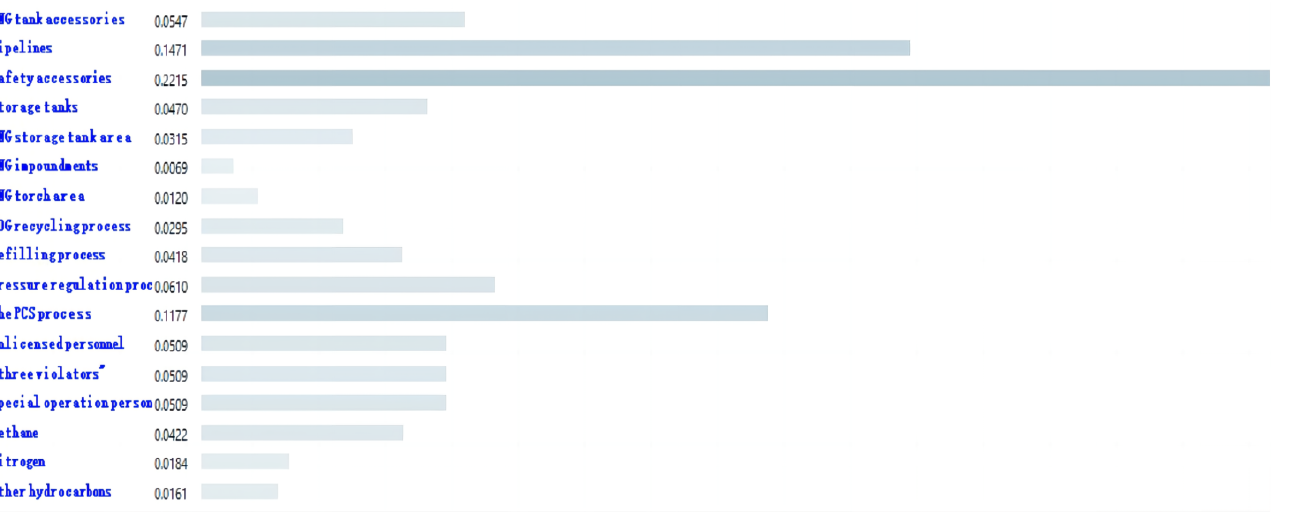
Figure 9. Comparison of weights in AHP and ANP. The analysis of the weights of ANP and AHP by SPSS shows that the range of the weights of ANP is 0.2099, and the range of AHP is 0.2146, R(AHP) > R(ANP). Figure 6 also clearly shows that the ANP exists in a relatively more balanced distribution of weights. Because of the network hierarchy of circular domination within the same level and the correlation between the elements, the ANP model incorporated a feedback mechanism. Therefore, to a certain extent, the priority of risk factors that can affect other elements is improved, making the weight of indicators closer to the actual situation. In Figure 9, the weights of some risk elements in ANP differ greatly from those in AHP. Due to the space limitation, “Pipelines” is used as an example in the paper. In actual production, many valves, flanges, and other safety accessories are installed on pipelines. Such type of security accessories is numerous and easily overlooked. This also explains